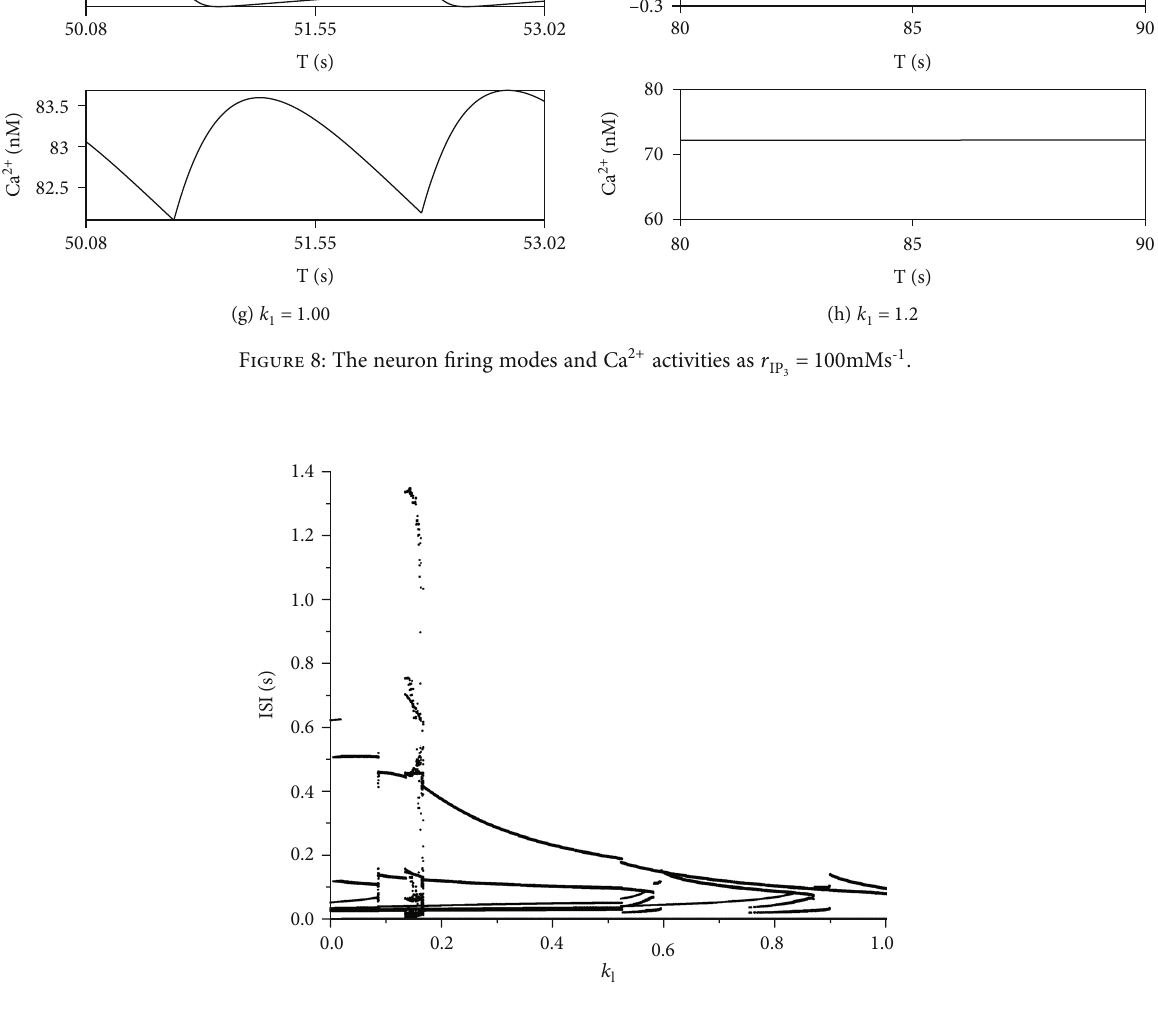
with r = 100mMs ‐ 1 1 IP 3